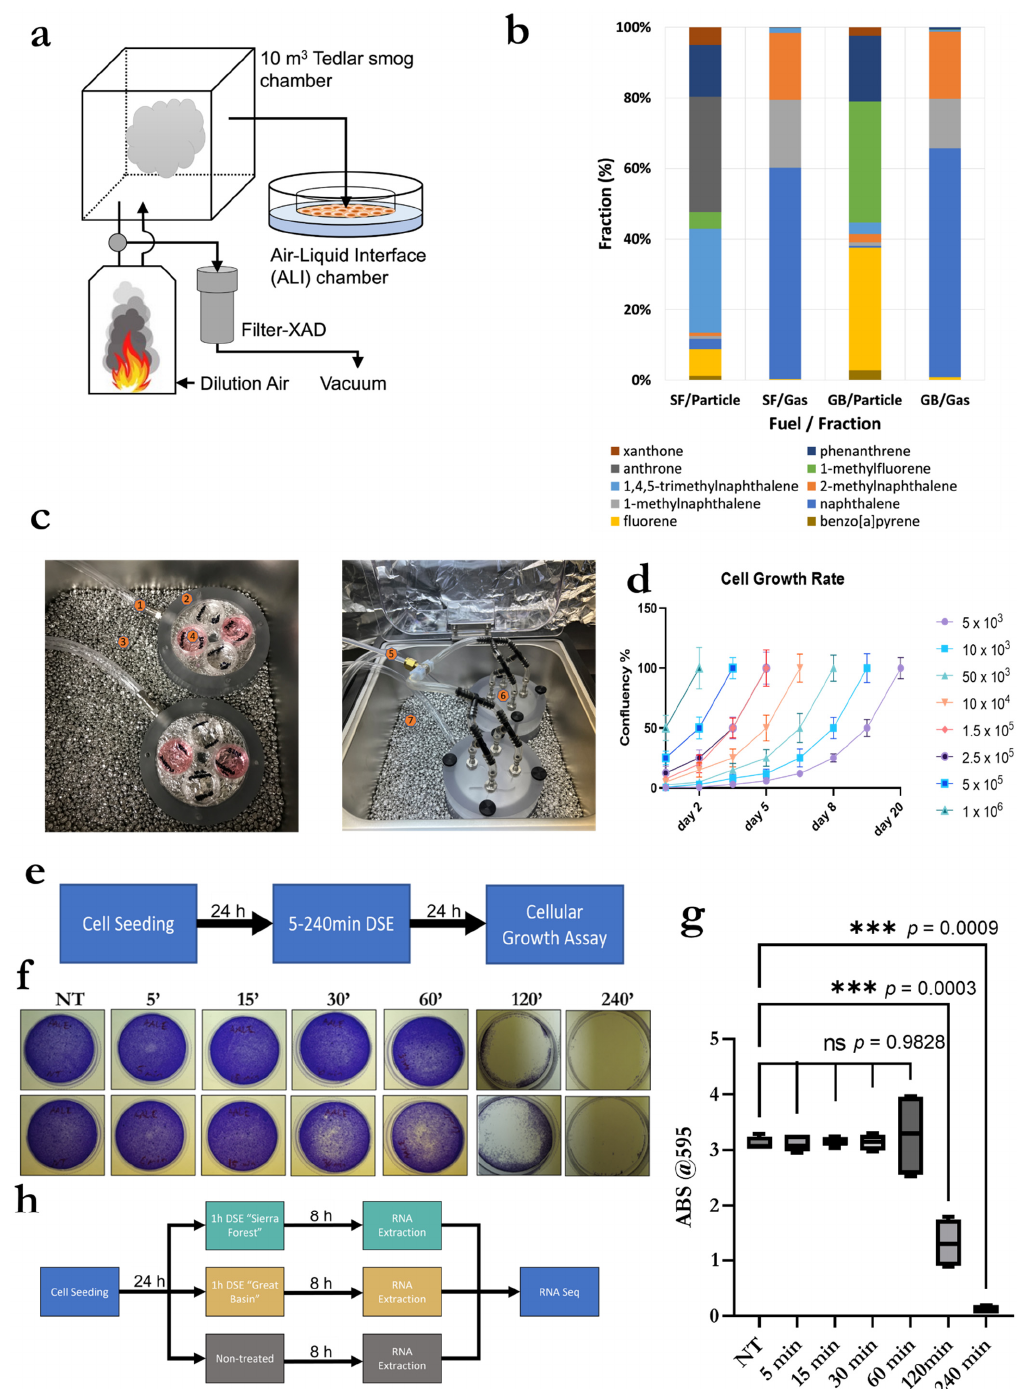
Figure 1. Direct smoke exposure affects cell viability in a time dependent manner. ( a ) Schematics of smoke exposure system; ( b ) Concentrations of most abundant Polycyclic aromatic hydrocarbon (PAH) compounds for two tested fuels; ( c ) In vitro exposure system setup consisting of smoke inlet (1, 5, and 6), ALI chamber housing. (2) In-vitro cell culture (4), and incubator with metal beads (3, 7); ( d ) Cell growth rates of AALE seeded and incubated within the exposure system; ( e ) Graphic representation of experimental design to validate cell viability in the ALI exposure system; ( f ) Crystal Violet assay performed on cells exposed to smoke in the ALI device; ( g ) Quantification of Crystal Violet results with statistical significance *** indicate a statistical significance with a p value < 0.001; ns indicates a non-significant statistical difference; ( h ) graphic representation of experimental design for sample collection for RNA seq